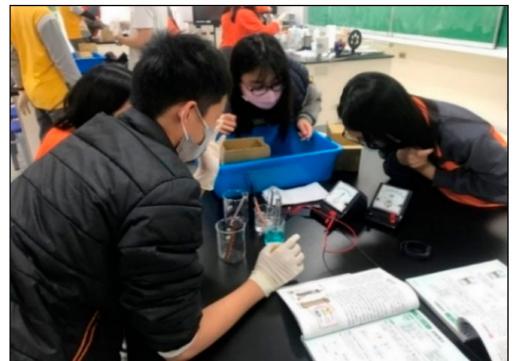
Figure 12. Control group conducting the real